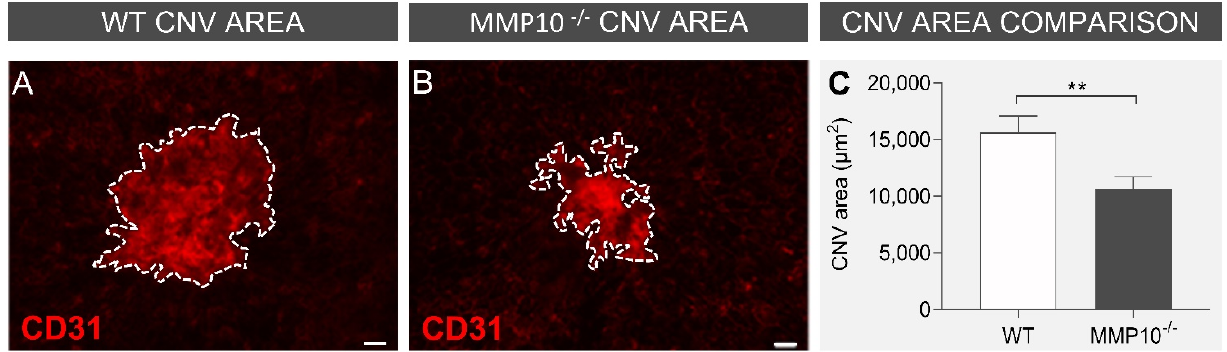
Figure 3. MMP10 ‐ / ‐ mice develop smaller CNV areas after laser injury. Representative laser ‐ induced CNV area stained with CD31 by immunofluorescence (red) from WT mice ( A ) and for MMP10 ‐ / ‐ mice in RPE ( B ). The dotted lines represent the edge of the CNV area. ( C ) Comparison of mean CNV area between WT and MMP10 ‐ / ‐ mice after laser ‐ induced CNV. AMD = age ‐ related macular degen ‐ eration, CNV = Choroidal neovascularisation, WT = wild type, MMP10 = Matrix metalloproteinase 10. Error bars correspond to SEM. ** p < 0.01. Scale bar: 20 μ m.